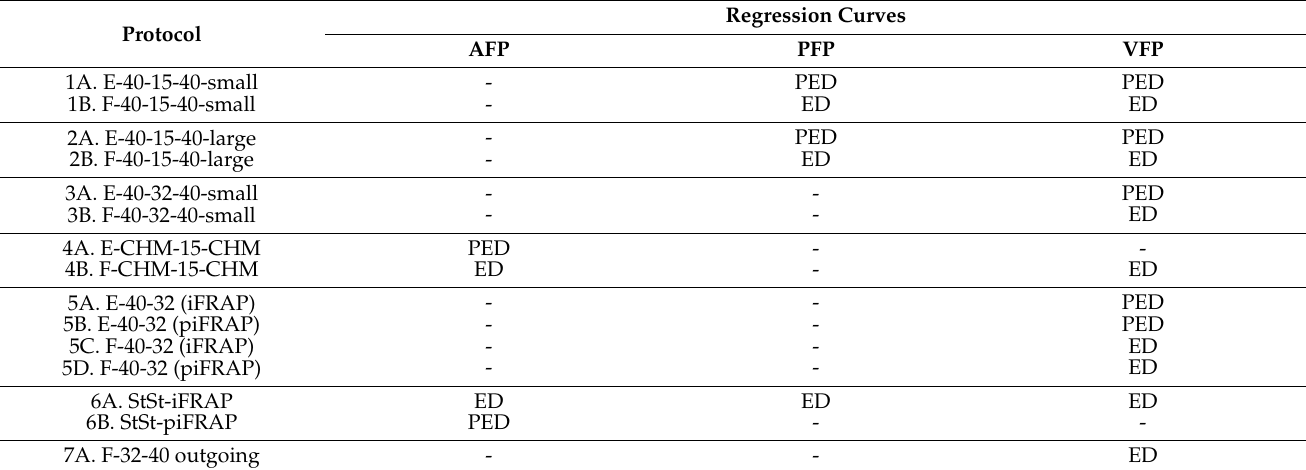
Table 4. Statistical analysis for goodness-of-fit of regression curves that describe the kinetics of cargo exit from the Golgi